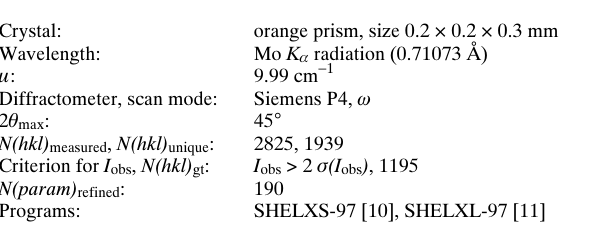
Table 1. Data collection and handling.